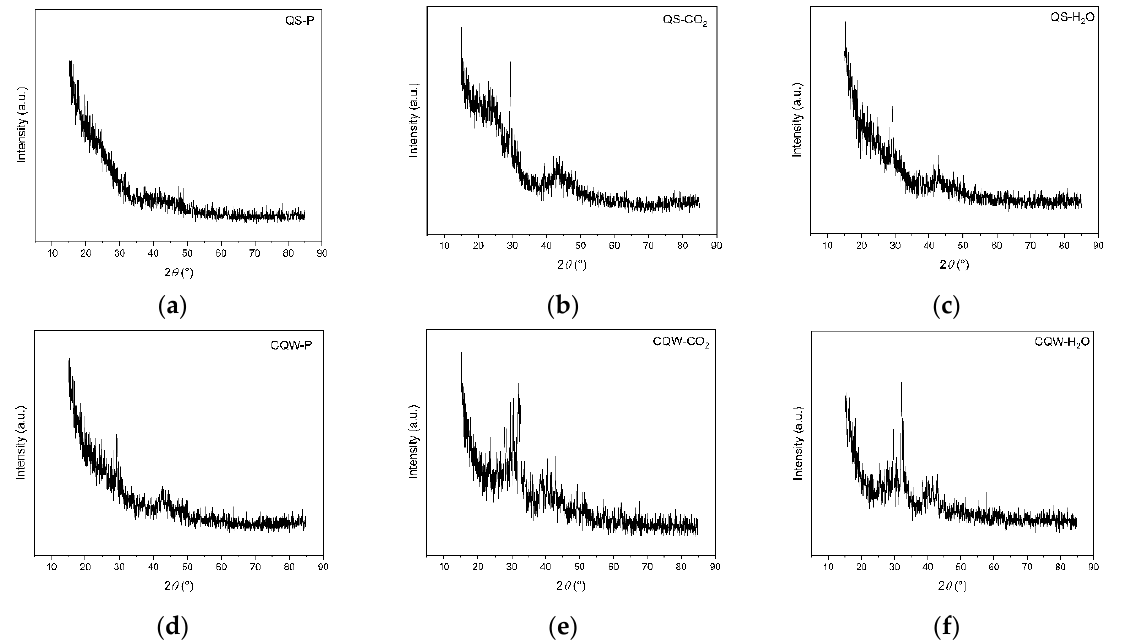
Figure 7. XRD patterns spectrum of QS-P ( a ), QS-CO 2 ( b ), QS-H 2 O ( c ), CQW-P ( d ), CQW-CO 2 ( e ), and CQW-H 2 O ( f ).